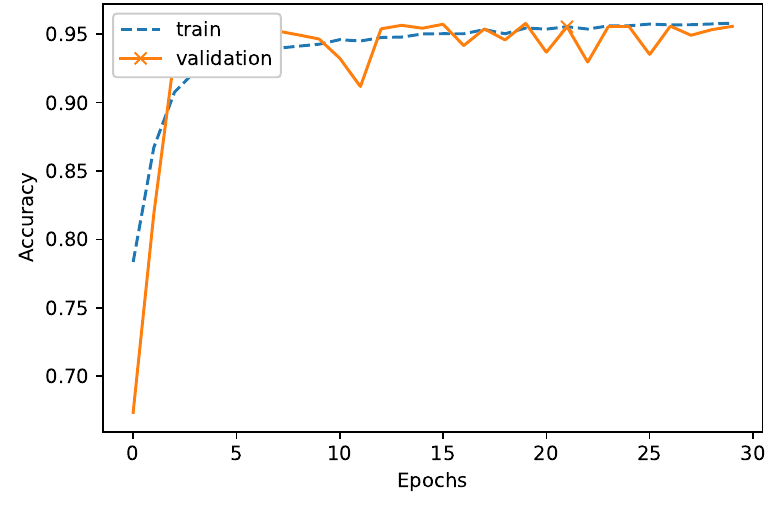
Figure 5. Performance convergence versus epochs.